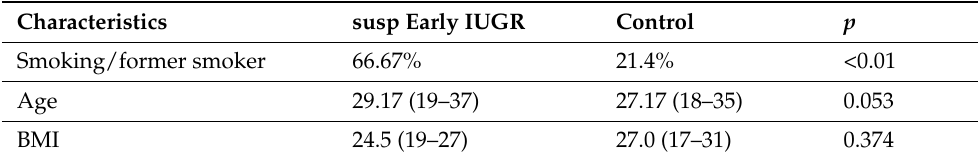
Table 1. Demographic maternal characteristics in pregnancies with suspected early IUGR and control group.